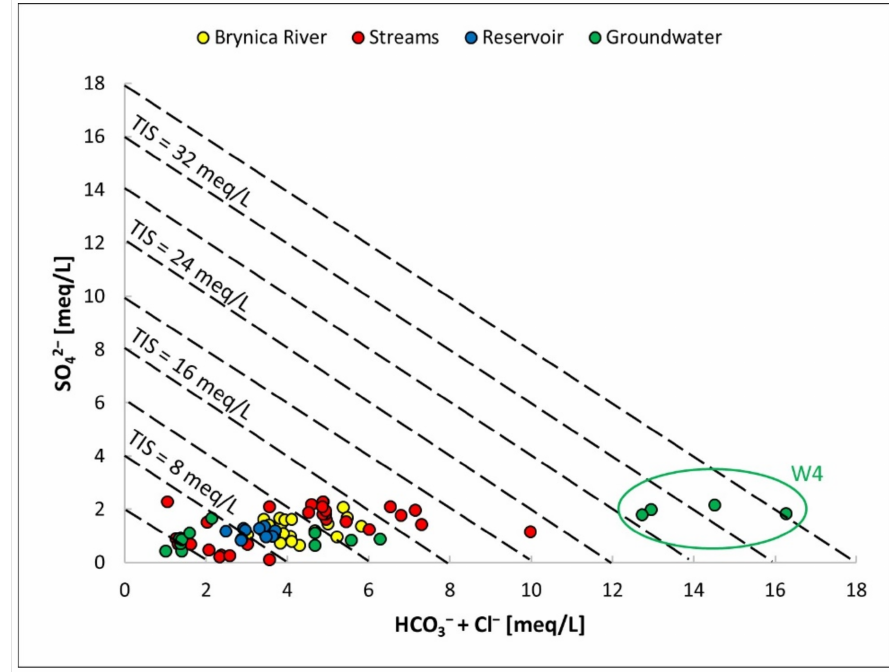
Figure 4. Concentrations of SO 42 − vs. (HCO 3 − + Cl − ) in the collected water samples. Concentrations of major ions in surface water were similar in warm seasons,